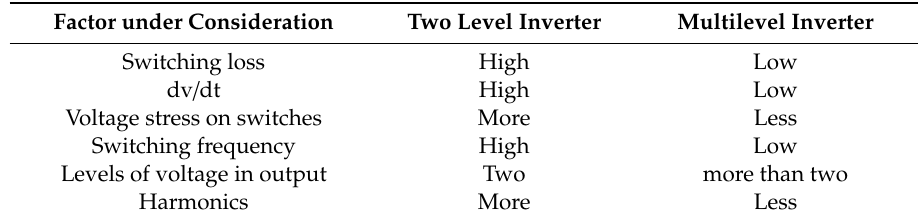
Table 1. Traditional two-level inverters Vs MLI.